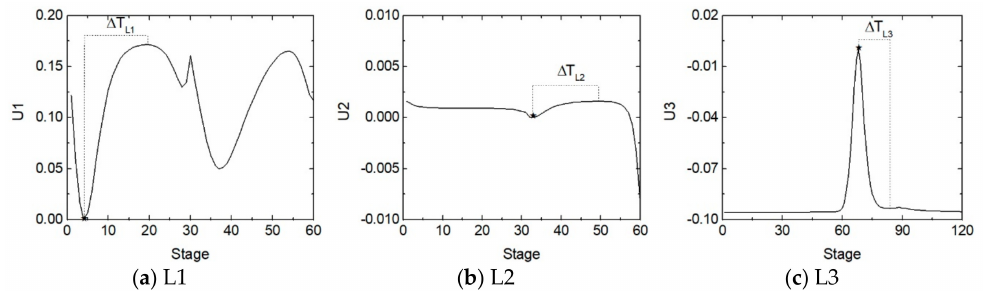
Figure 5. Singular value decomposition analysis profiles for the simplified temperature di ff erence